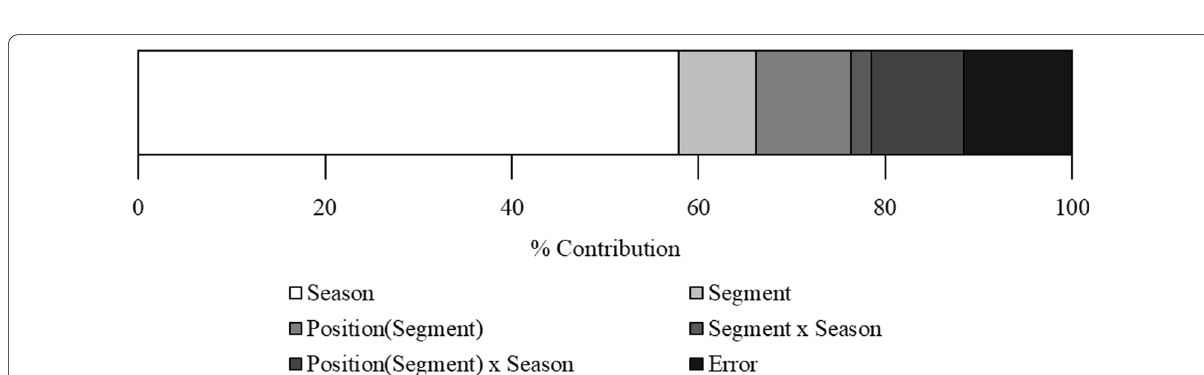
Fig. 5 Percent contribution of factors in a general linear mixed effects model assessing effects of season, segment, position and their interactions on % tensile loss/day. Grey scale from light to dark represents % contribution of season, segment, position (segment), segment x season, position (segment) season, and ×